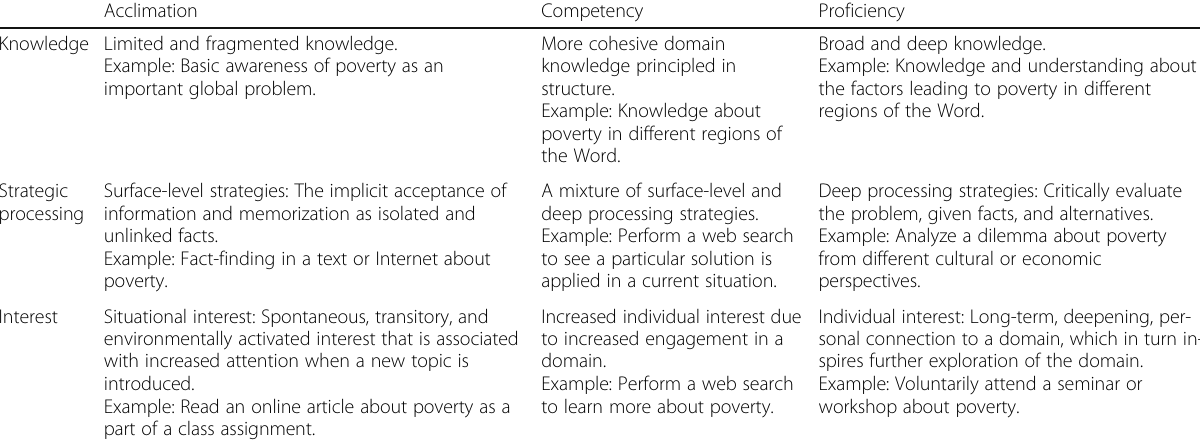
Table 1 Description and examples of the MDL components and stages Acclimation Competency